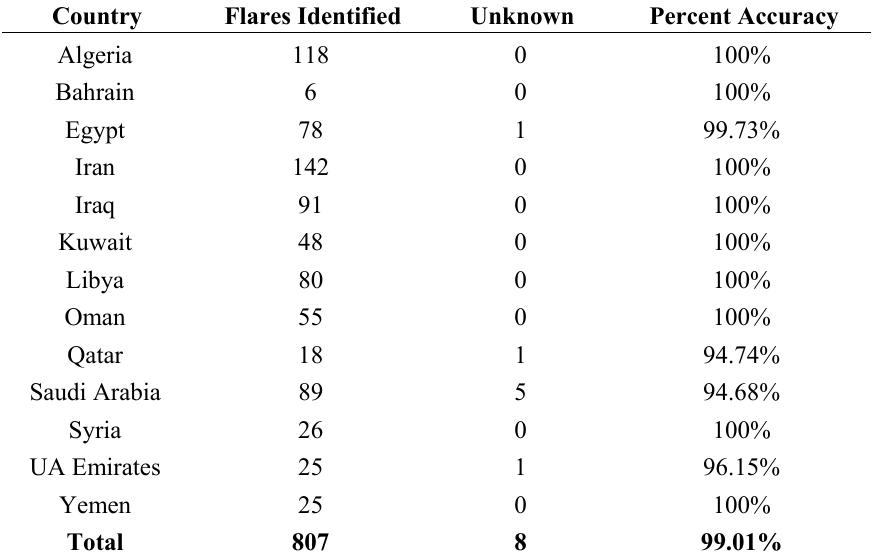
Table 4. Percent accuracy of Nightfire gas flare identifications from January